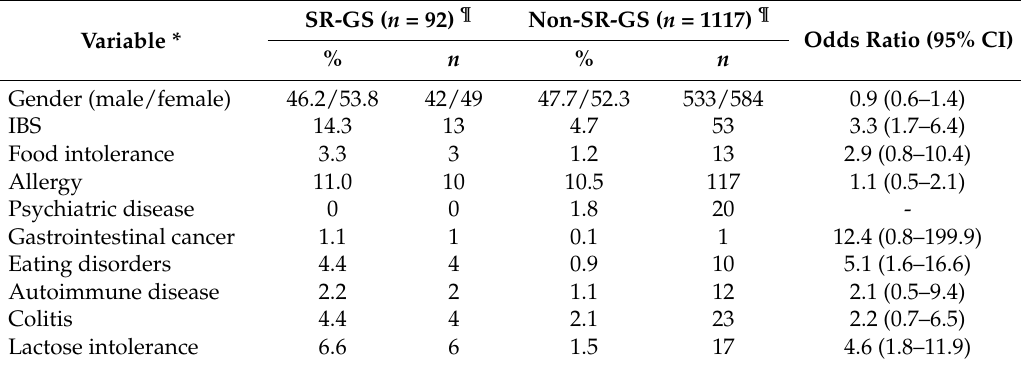
Table 3. Comparison between self ‐ reported gluten sensitivity (SR ‐ GS) and non ‐ self ‐ reported gluten sensitivity (non ‐ SR ‐ GS).